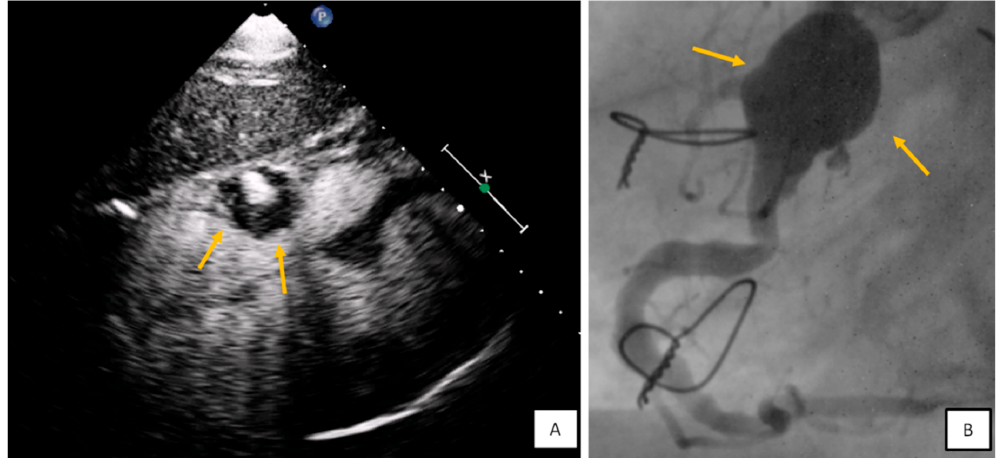
Figure 10. ( A ) Subxiphoid view with contrast agent. Round mass with mural thrombus and blood flow at the level of tricuspid annulus findings consistent with right coronary artery (RCA) aneurysm. ( B ) Coronary angiography confirmed the diagnosis.